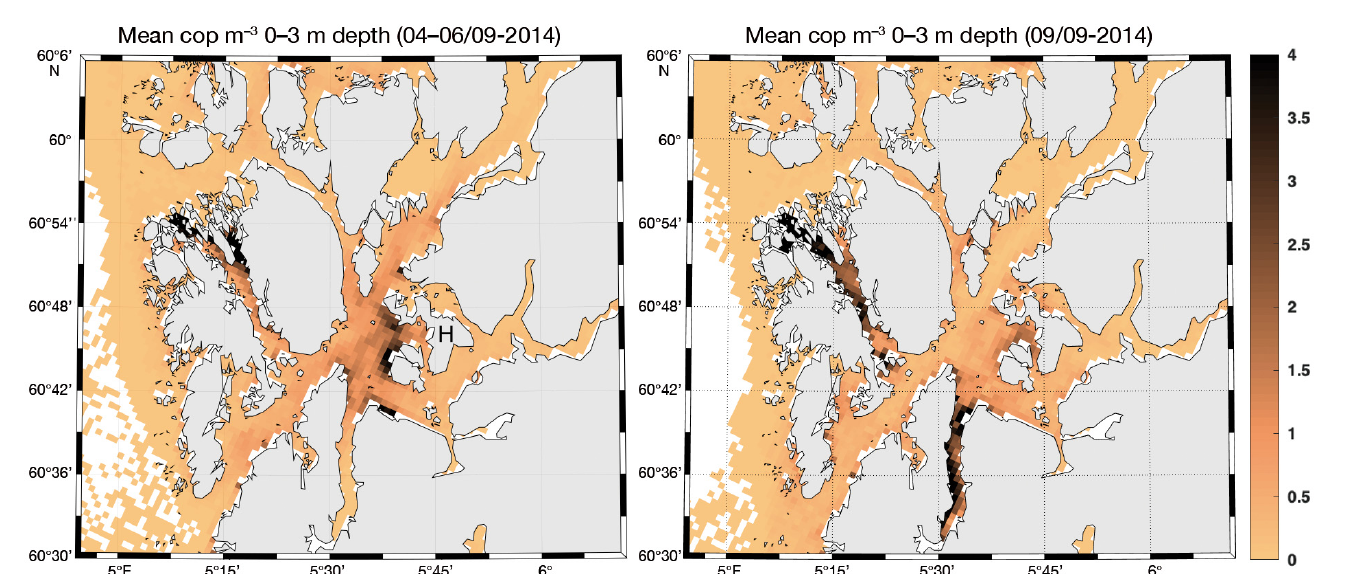
Fig. 4. Modelled abundance of salmon lice copepodids in Hardanger fjorden: mean concentrations (ind. m −3 ) of lice copepo- dids (cop) per grid cell (area 800 × 800 m 2 ) at 0 to 3 m depth averaged over 3 d (left panel), corresponding to the cruise of